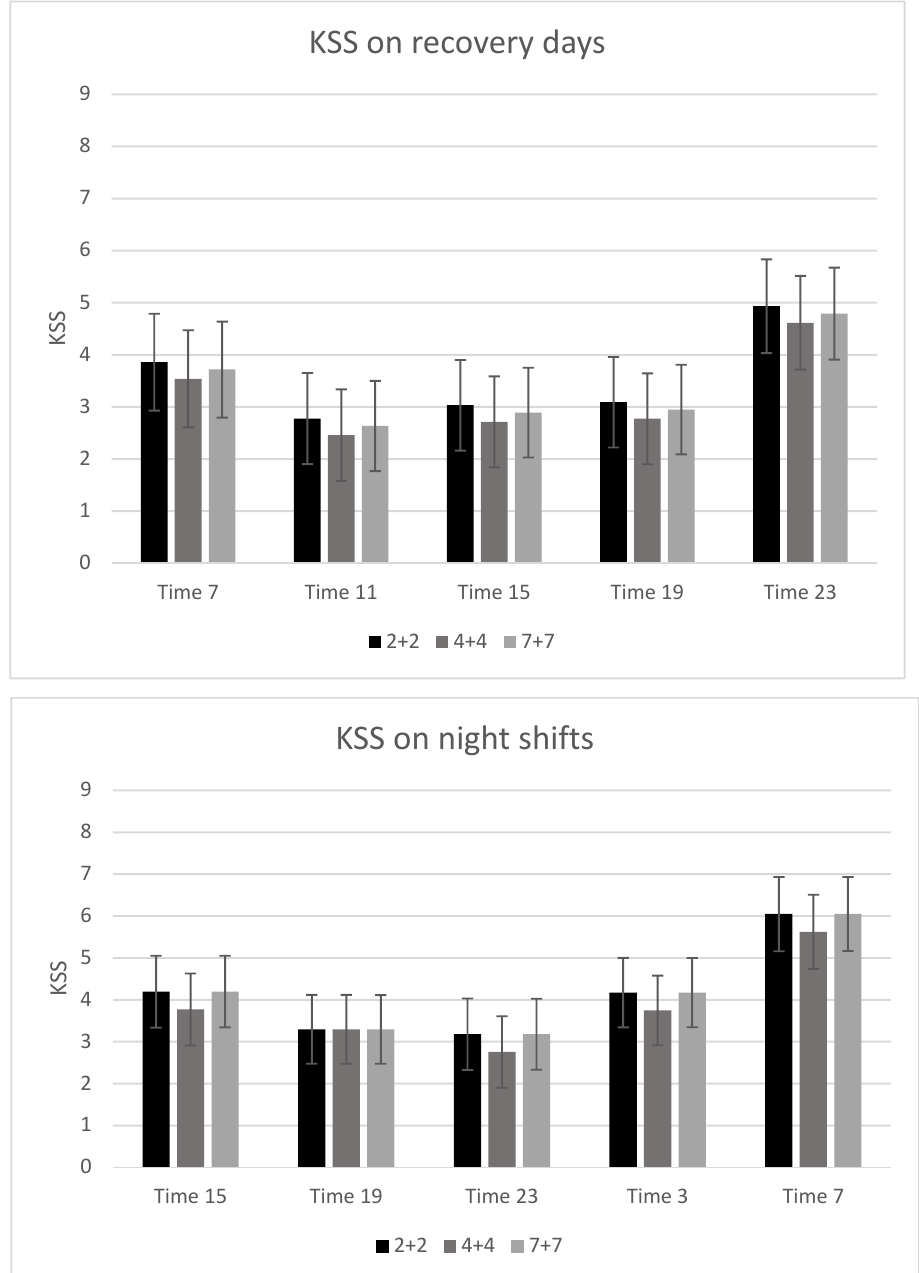
Figure 2. Estimates of KSS in the three different work schedules. KSS was measured every 4th hour at 07:00, 11:00, 15:00, 19:00, 23:00, and 03:00. Schedule 2+2 refers to 2 night shifts followed by 2 recovery days and is shown in black. Schedule 4+4 refers to 4 night shifts followed by 4 recovery days and is shown in dark grey. Schedule 7+7 refers to 7 night shifts followed by 7 recovery days and is shown in light grey. The error bars indicate 95% confidence interval.